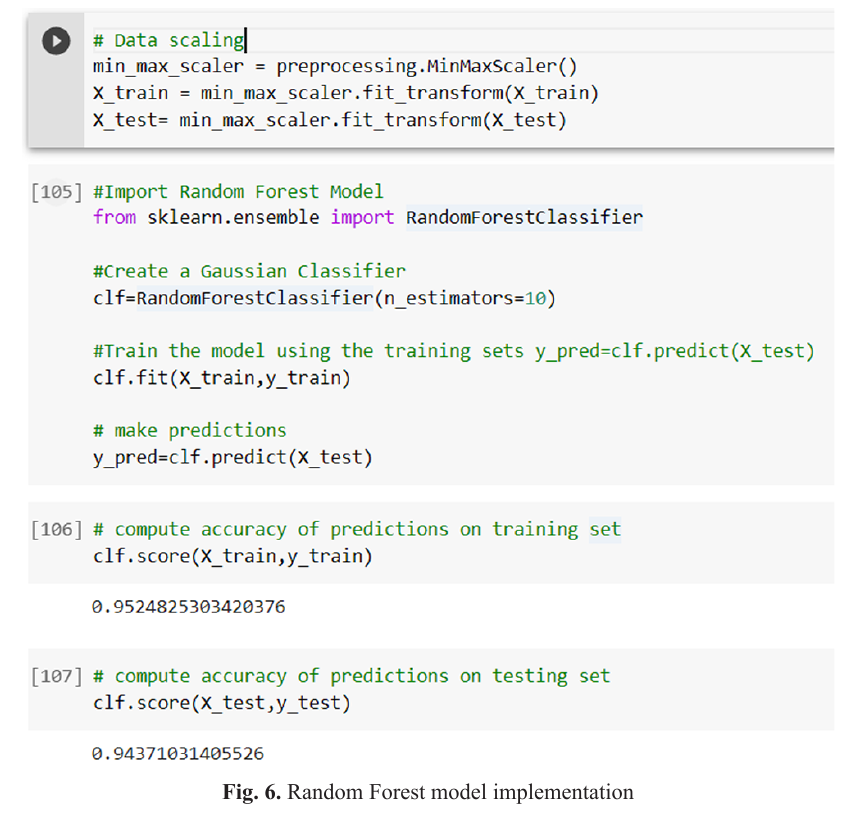
Fig. 6. Random Forest model